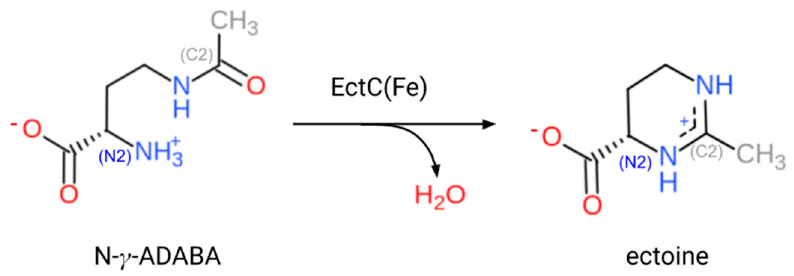
Figure 1. EctC-catalyzed cyclocondensation of N- γ -acetyl-L-2,4-diaminobutyric acid to ectoine with water elimination.